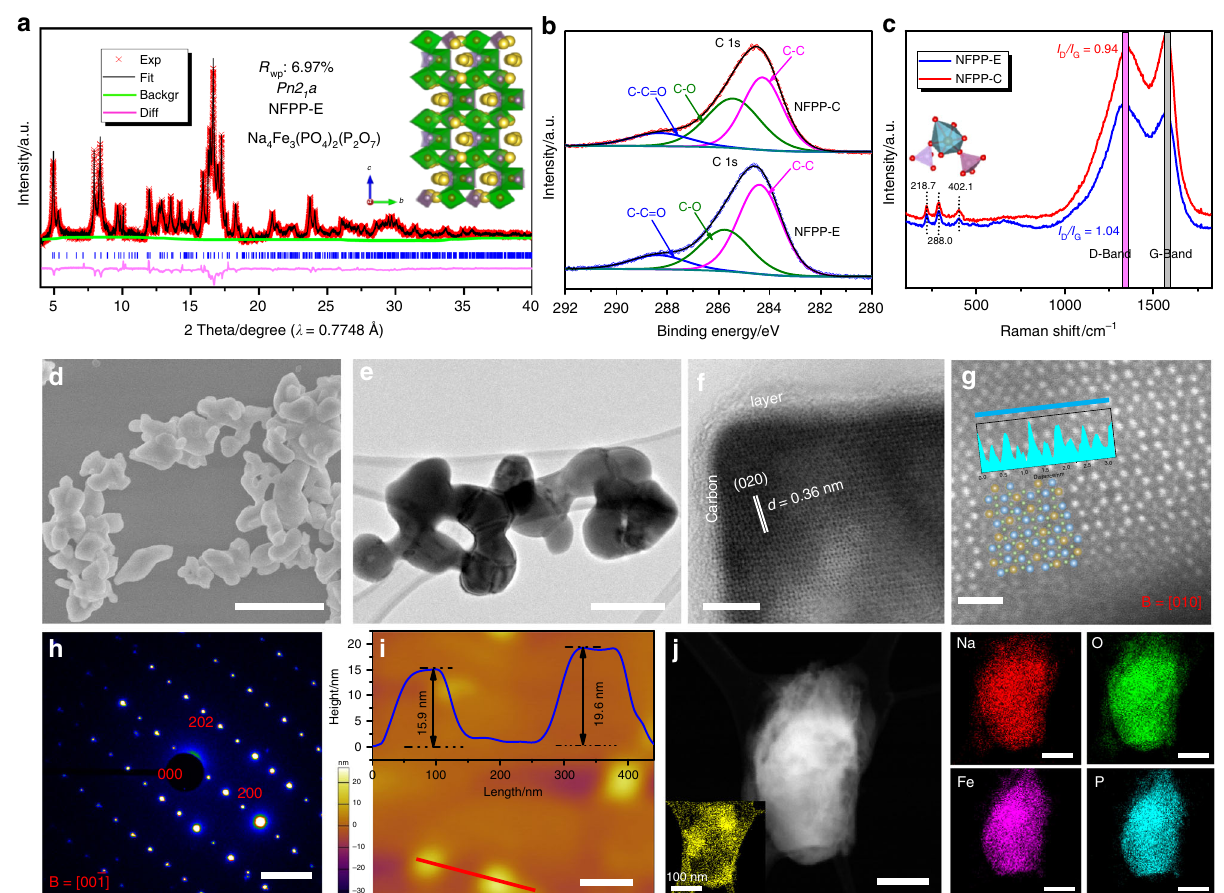
Fig. 1 Characterizations of as-prepared sample. Rietveld re fi nements of a NFPP-E. Schematic representation of the re fi nement results is presented in the insets. b XPS spectra of C 1s and the corresponding deconvolution curves of both NFPP-E and NFPP-C samples. c Raman spectra of both samples in the Raman shift range from 100 cm − 1 to 1800 cm − 1 . d SEM images of NFPP-E and e transmission electron microscope (TEM) image of NFPP-E particles. f Bright fi eld (BF) image of NFPP-E with carbon layers. g HAADF image from aberration-corrected STEM and the crystal structure of NFPP-E viewed from the [010] direction. The insets are the corresponding signal responses along the selected lines. h The corresponding SAED pattern of NFPP-E and i atomic force microscopy (AFM) image of NFPP-E nanoplate particles and their corresponding heights. j The STEM-EDS mapping results for selected elements of NFPP-E. Scale bars: 500 nm ( d ); 200 nm ( e ); 5 nm ( f ); 1 nm ( g ); 2 1/nm ( h ); 200 nm ( i ); 100 nm ( j Fig. 1c. The detected peaks at 218.7 cm − 1 and 288.0 cm − 1 can be assigned to the stretching vibrations and bending motions of the PO 4 tetrahedra, respectively, and the peak located at 402.1 cm − 1 is mainly due to the stretching vibrations of FeO 6 octahedra 34 . It is worth noting that the intensity ratio of the D band to the G band ( I D / I G ) for the NFPP-E sample (1.04) is larger than that for the NFPP-C sample (0.94). The D-band is mainly due to defects, edges, or structural disorder while the G-band normally represents the E 2g mode of sp 2 carbon layers. This phenomenon indicates that the carbon conductivity of the NFPP-E particle surface would be higher than that of NFPP-C, which is in good accordance the C 1 s deconvolution curves in Fig. 1b. The typical vibration modes of both the PO 4 units and the FeO 6 octahedra were also detected in the Fourier transform infrared (FT-IR) spectrum (Supplementary Fig. 5). The predominant overlapped peak of the v 1 and v 3 symmetric and asymmetric stretching modes of the PO 4 units is around 1109 cm − 1 , while the v 2 and v 4 symmetric and asymmetric bending modes of the PO 4 tetrahedra are responsible for the splitting of the O-P-O peaks in the range from 590 to 740 cm − 1 . The peak around 543 cm − 1 represents the vibration of the bonds between Fe 2 + and O 2 − in the isolated FeO 6 octahedra 19 . The presence of O-C = O (2361 cm − 1 )